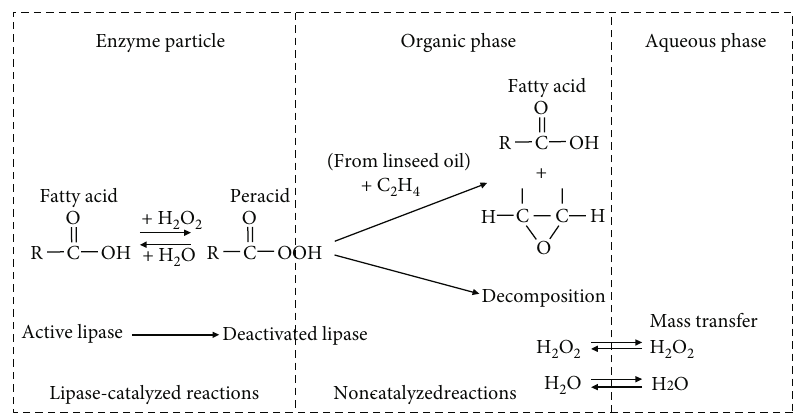
Figure 3: Reaction of chemoenzymatic epoxidation [27].